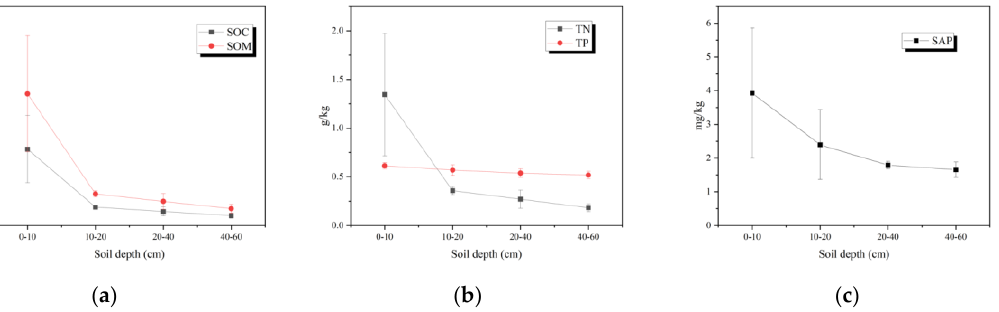
Figure 4. Changes of soil nutrients properties (( a ) means soil organic carbon, soil organic matter, ( b ) means total soil nitrogen, total soil phosphorus, ( c ) means soil available phosphorus) with soil depth. Table 1. Soil physical-chemical properties in Acacia Communities.